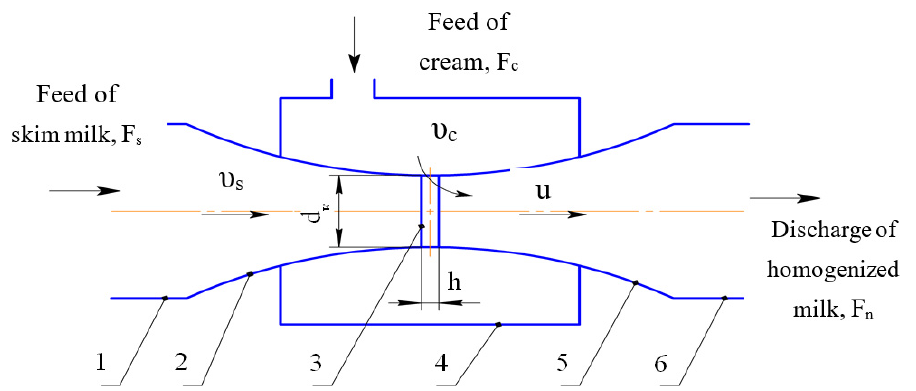
Figure 1. Scheme of the homogenizing unit of the jet-slot homogenizer of milk with a separate sup- ply of the fat phase: 1—the supply pipe of skim milk; 2—confusor; 3—annular gap; 4—container with cream; 5—diffuser; 6—homogenized milk discharge nozzle; F s —fat content of skim milk; υ s —speed of supply of skim milk; d k —the diameter of the confusor at the point of greatest narrowing; h is the width of the annular gap; υ c —cream feeding speed; F c —fat content of cream; u—sliding speed of fat globules relative to milk plasma; and F n —fat content of milk after normalization and homogenization.